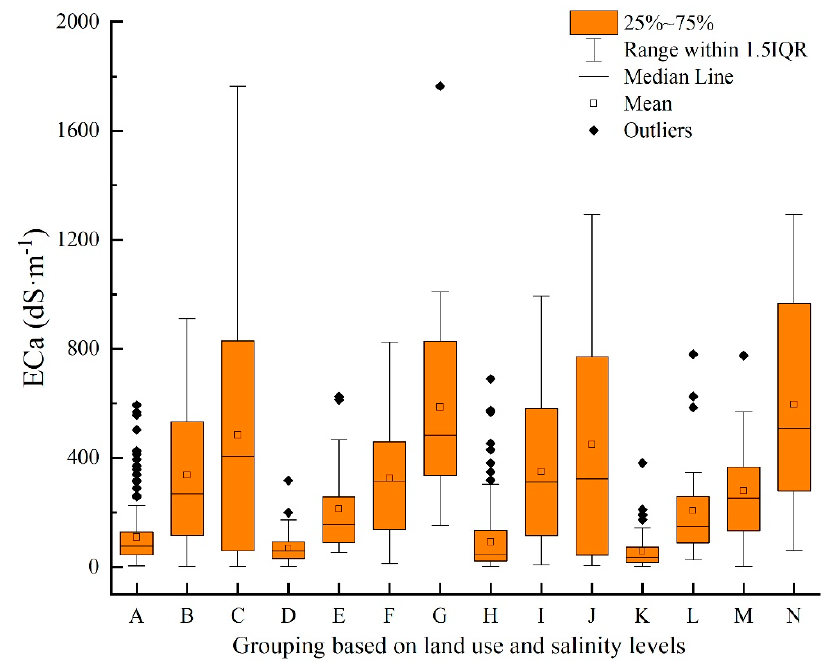
Figure 2. Calculated ECa box plot based on land use and salinity levels. A and H—farmland; B and I—shrub/grass; C and J—bare land; D and K—non-saline soil; E and L—slight and moderate saline soil (2–8 dS·m − 1 ); F and M—severe saline soil (8–16 dS·m − 1 ); G and N—extreme (>16 dS·m − 1 ); A—G stands for EC av01 ; H–N stands for EC ah05 . Table 3. Pearson’s correlation coe ffi cient among soil salinity at di ff erent depths ( n =